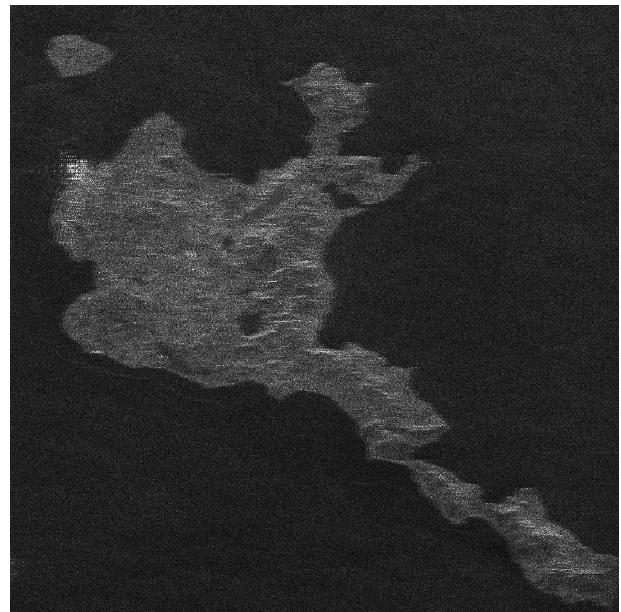
Figure 17. The result of using the RD algorithm when the Sentinel-1 azimuth periodically missing data (vertical range, horizontal azimuth).